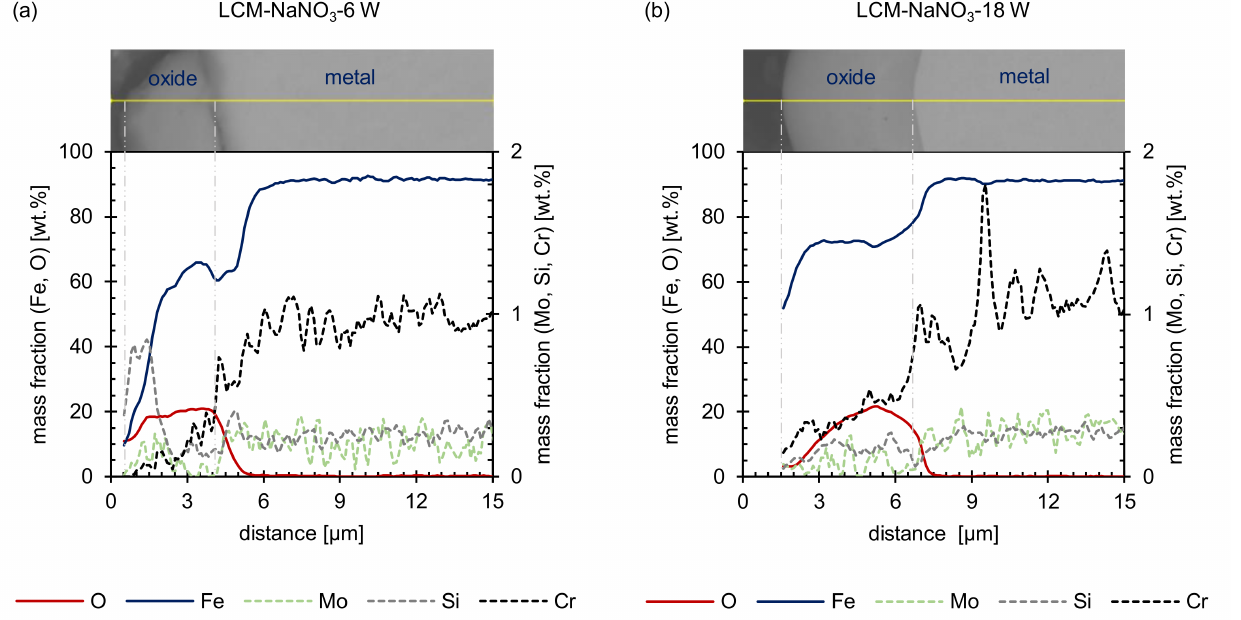
Figure 4. EDS line scans before oxidation: ( a ) LCM-NaNO 3 -6W and ( b ) LCM-NaNO 3 -18W 42CrMo4